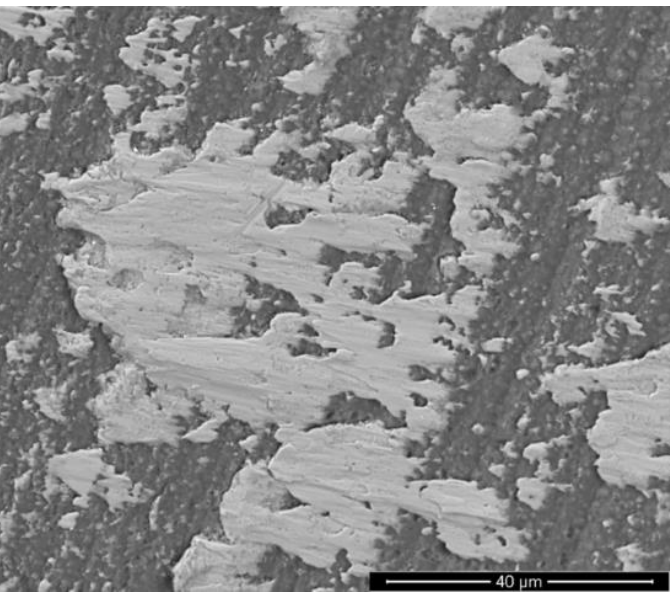
Figure 5. Adhered workpiece material present in the T1L4F100 tool’s rake face, with a magnification of 2500×.